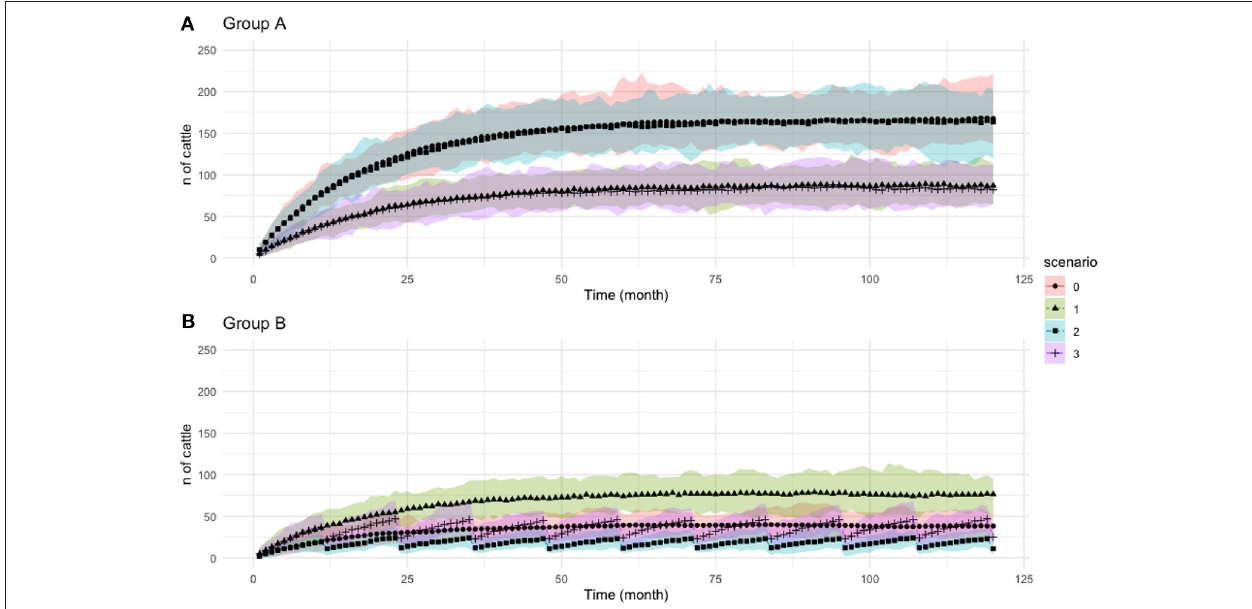
FIGURE 5 | Population of persistently infected (PI) animals over time. (A) Population in Group A. (B) Population in Group B. Legend color and shape represent different scenarios for each group. For every colored shade presented the range of values obtained from 100 simulations, upper shade is the maximum value and lower shade is the minimum. Each shape in each scenario presents the mean value. Scenario 0 represent baseline scenario. The y -axis is the number of cattle and x -axis is monthly time step.